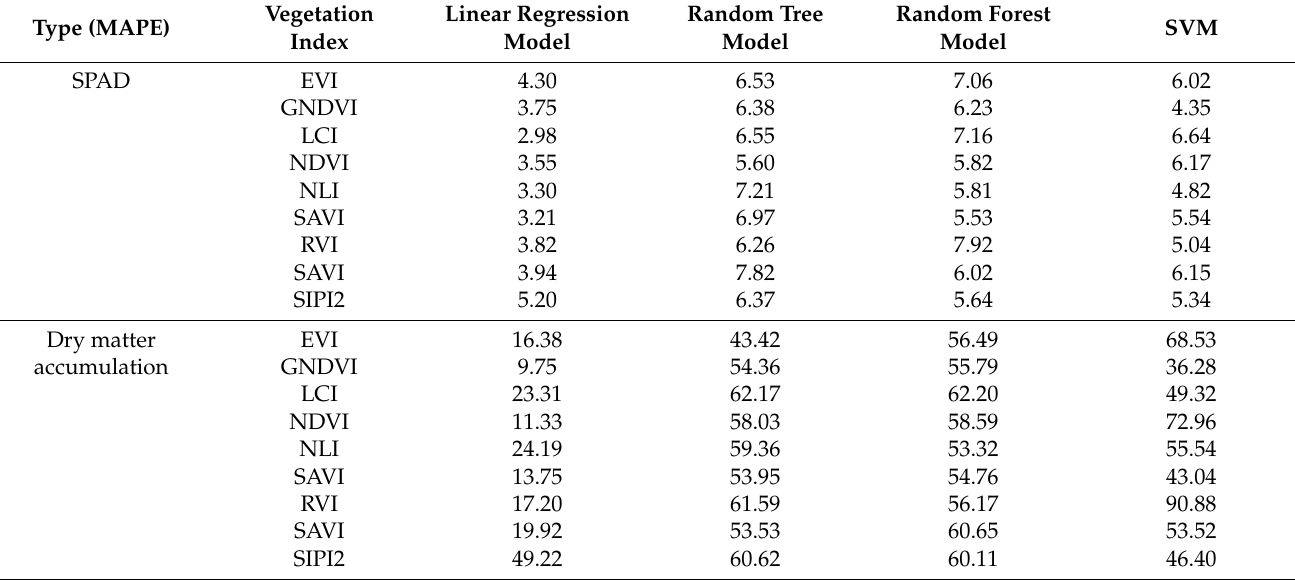
Table 5. Comparison of prediction accuracy of single-factor regression